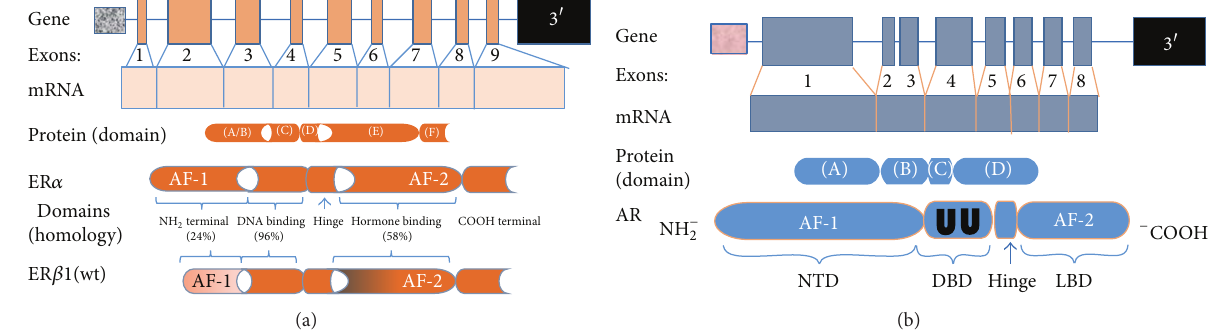
Figure 1: (a) Characterization of the estrogen receptor gene and protein. ER 𝛼 and ER 𝛽 are encoded by two distinct genes; the ER 𝛼 gene is localized to chromosome 6q24–27; the ER 𝛽 gene is located on chromosome 14q21-22. The gene transcripts are composed of 9 exons. The two encoded proteins differ in number of amino acids with ER 𝛼 being slightly longer, 595 versus 530. Both proteins have five distinct domains, three of which have relative degrees of homology. The domain with the greatest disparity resides in the A/B domain, which may account for many of the antagonistic actions observed between the two ERs. (b) Characterization of the androgen receptor gene and protein. The human androgen receptor gene is situated on the long arm of the X-chromosome, q11-12. The organization of the protein coding region is similar to that of the estrogen receptor but is divided over 8 exons. The sequence encoding the N-terminal domain (NTD) is found in exon 1. Similar to the ER, the functionality of the DNA-binding domain (DBD) is provided by a motif comprised of two zinc fingers (UU) encoded by exons 2 and 3. The first zinc finger mediates DNA recognition while the second mediates DNA-dependent dimerization. Message for the ligand-binding domain (LBD) is distributed over the remaining five